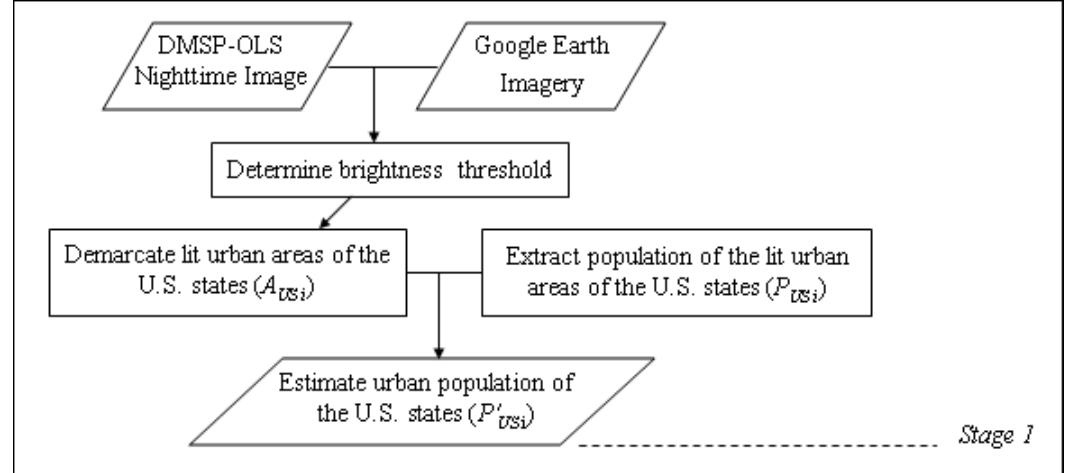
Figure 4. Stage 1 of the model: outputs are Estimated urban population of the U.S. states and the corresponding regression model parameters used to estimate the urban population of Mexico in Stage 3.